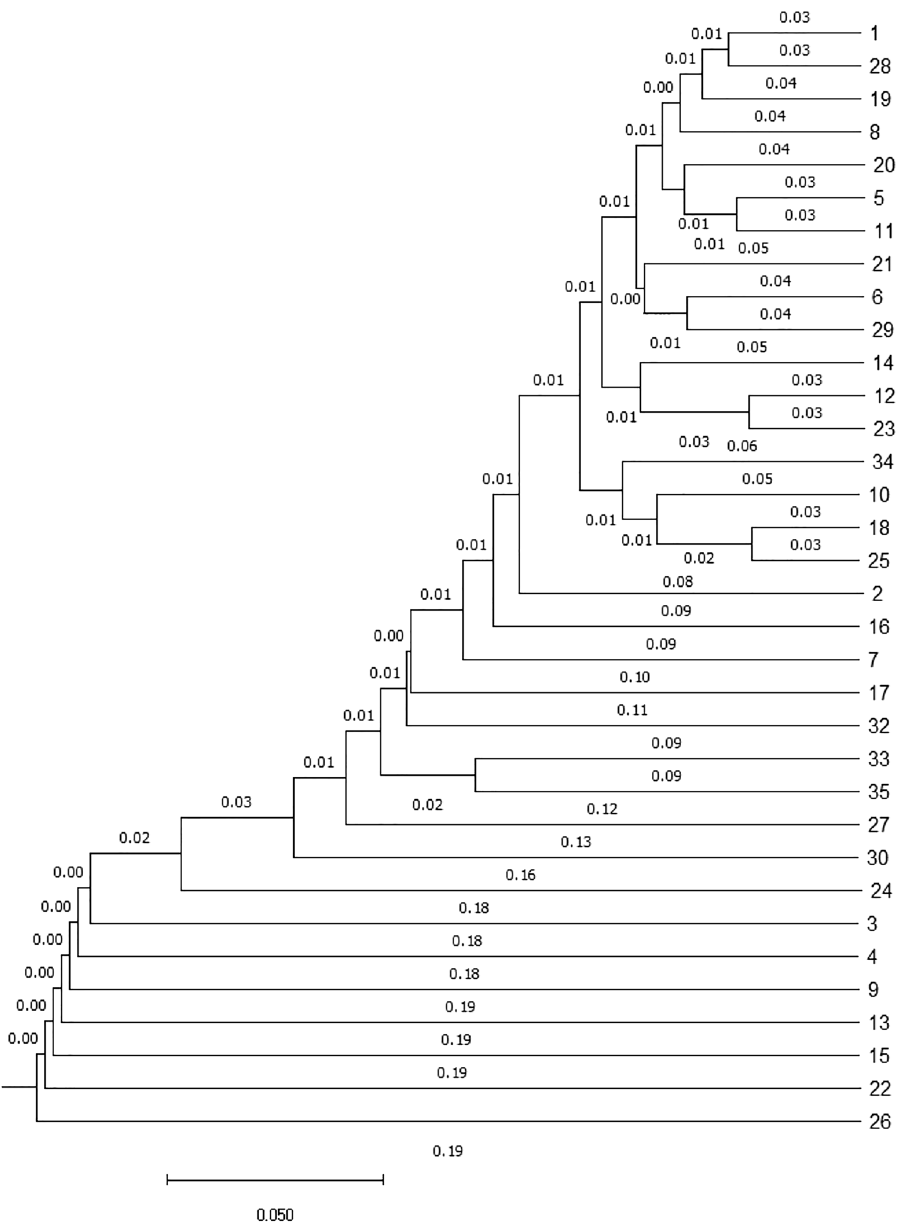
Figure 5. Cladogram constructed from Nei’s genetic distances among EAZA member institutions that house white-naped mangabeys in their